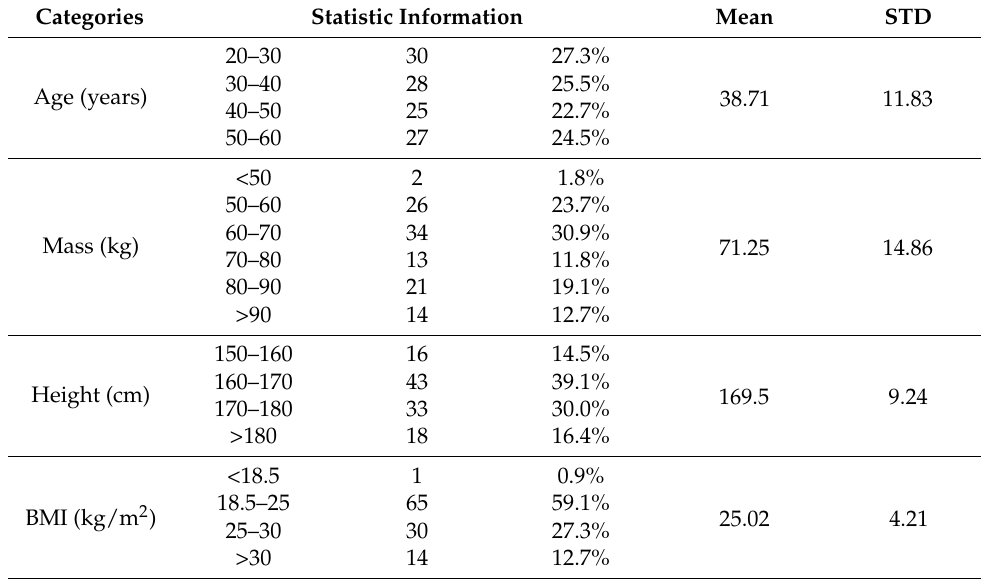
Table 1. Statistic distribution and characteristics of the participants.